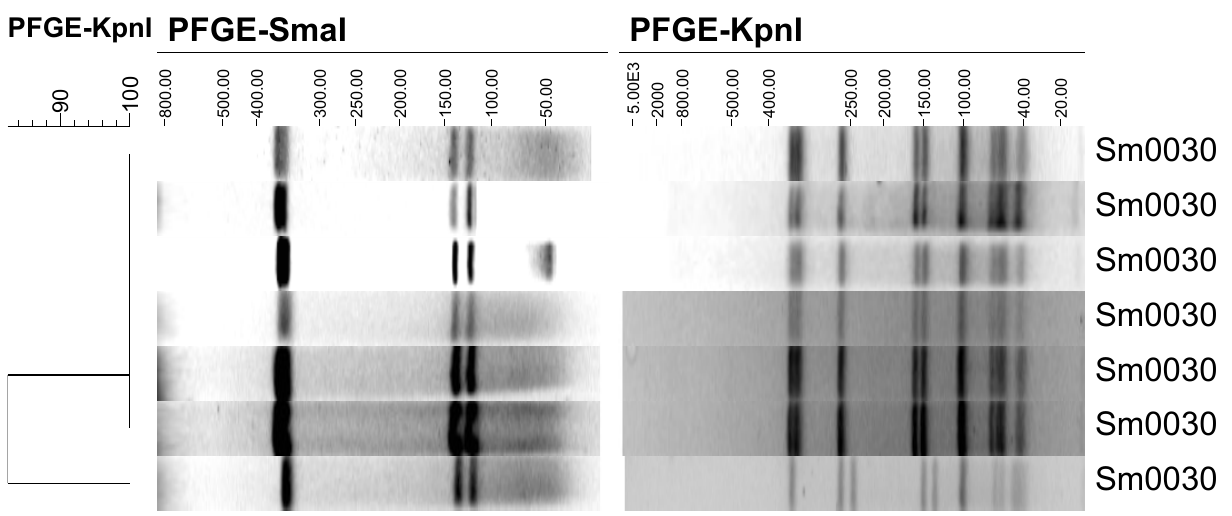
Figure 2. Clonal relationships between Campylobacter jejuni human isolates and subtype Sm0030/Kp0056 from chicken meat.